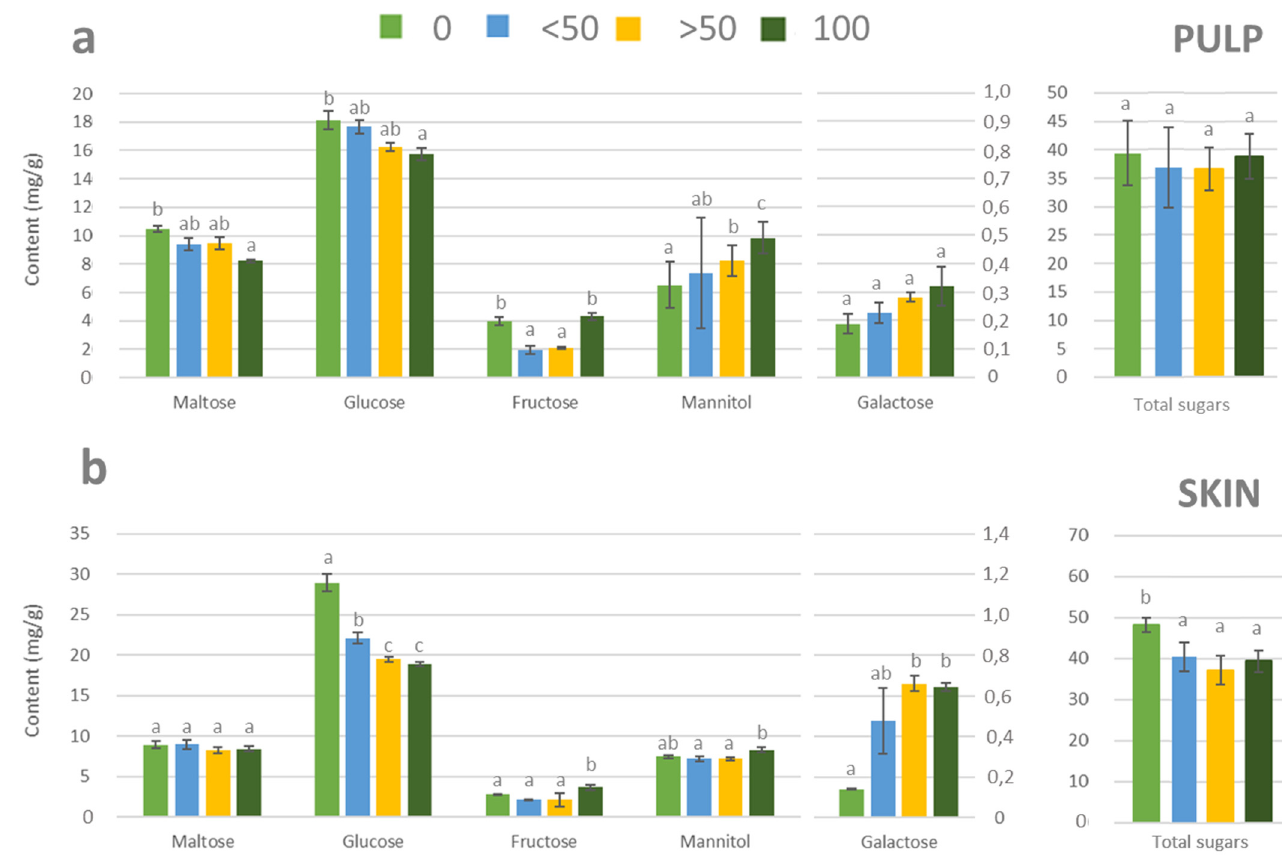
Figure 2. Sugar content (mg/g FW) of cultivar ‘Leccino’ in pulp ( a ) and skin ( b ) during ripening. The content is expressed as the mean ± standard error ( n = 4). Different letters indicate statistically significant differences between ripening stages ( p ≤ 0.05).